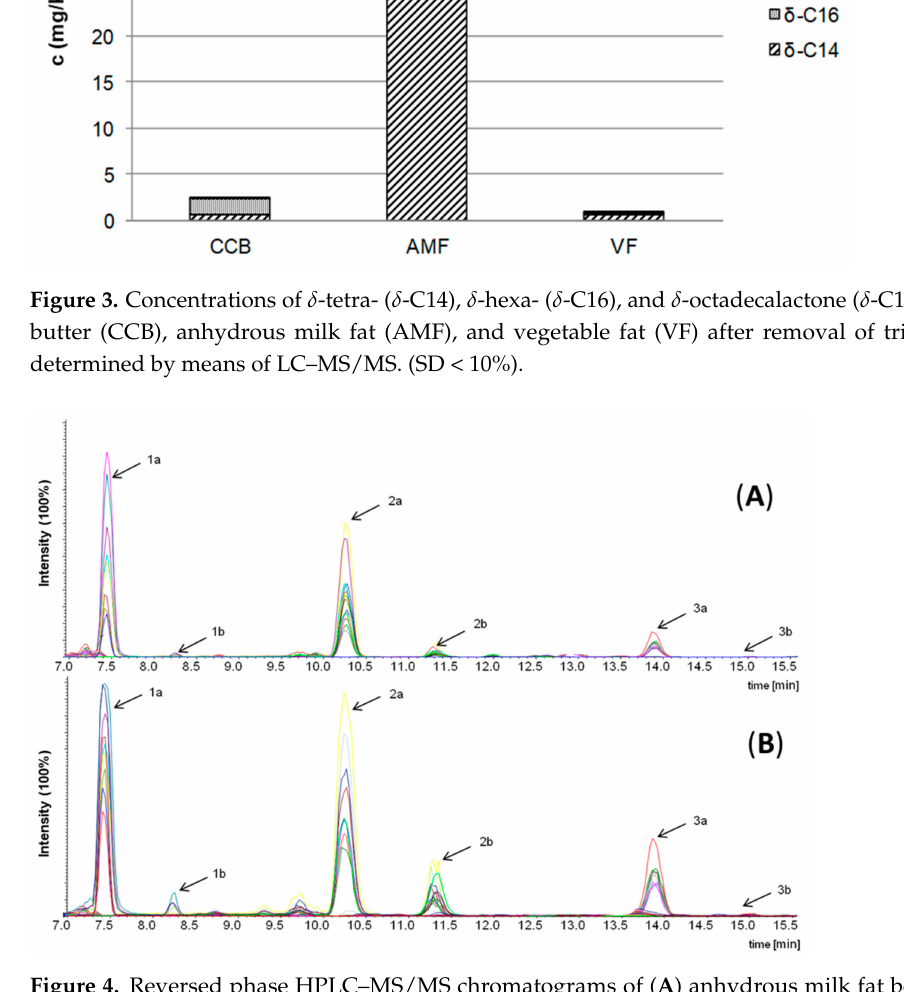
Figure 4. Reversed phase HPLC–MS/MS chromatograms of ( A ) anhydrous milk fat before high- vacuum distillation (acetonitrile solubles) and ( B ) semi-volatile isolates obtained by high-vacuum distillation of the anhydrous milk fat at 150 ◦ C (acetonitrile solubles): 1a, δ -tetra-( δ -C14); 1b, γ - tetradecalactone ( γ -C14); 2a, δ -hexa-( δ -C16); 2b, γ -hexadecalactone ( γ -C16); 3a, δ -octa- ( δ -C18); 3b, γ -octadecalactone ( γ